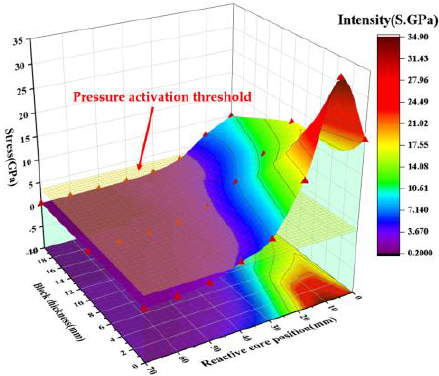
Figure 11. Changes in internal stress under different metal block thicknesses(red triangles: peak internal stress of the reactive core).